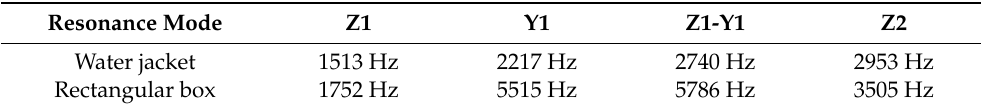
Table 2. Resonance frequencies and modes of the acoustic model of the water jacket and theoretical rectangular